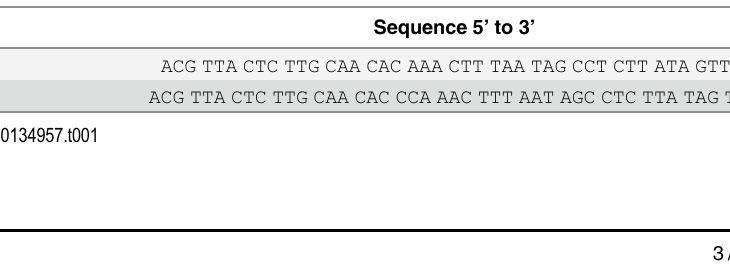
Table 1. Primary sequences of aptamers used in the